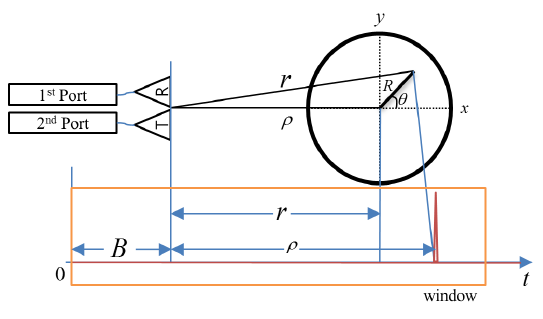
Figure 3. The delays for the propagation and RF components are represented. Both the measurement window in the time domain of the received signal and the geometry of the radar imaging system are